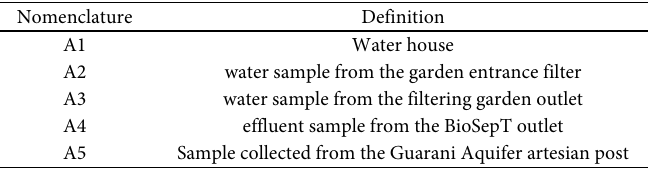
Table 2. Nomenclature assigned to collected